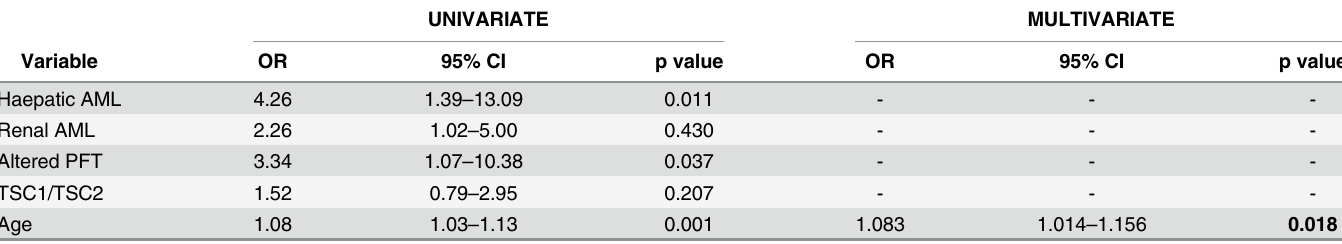
Table 4. Multivariate Analysis and ODDS RATIO for LAM risk in overall